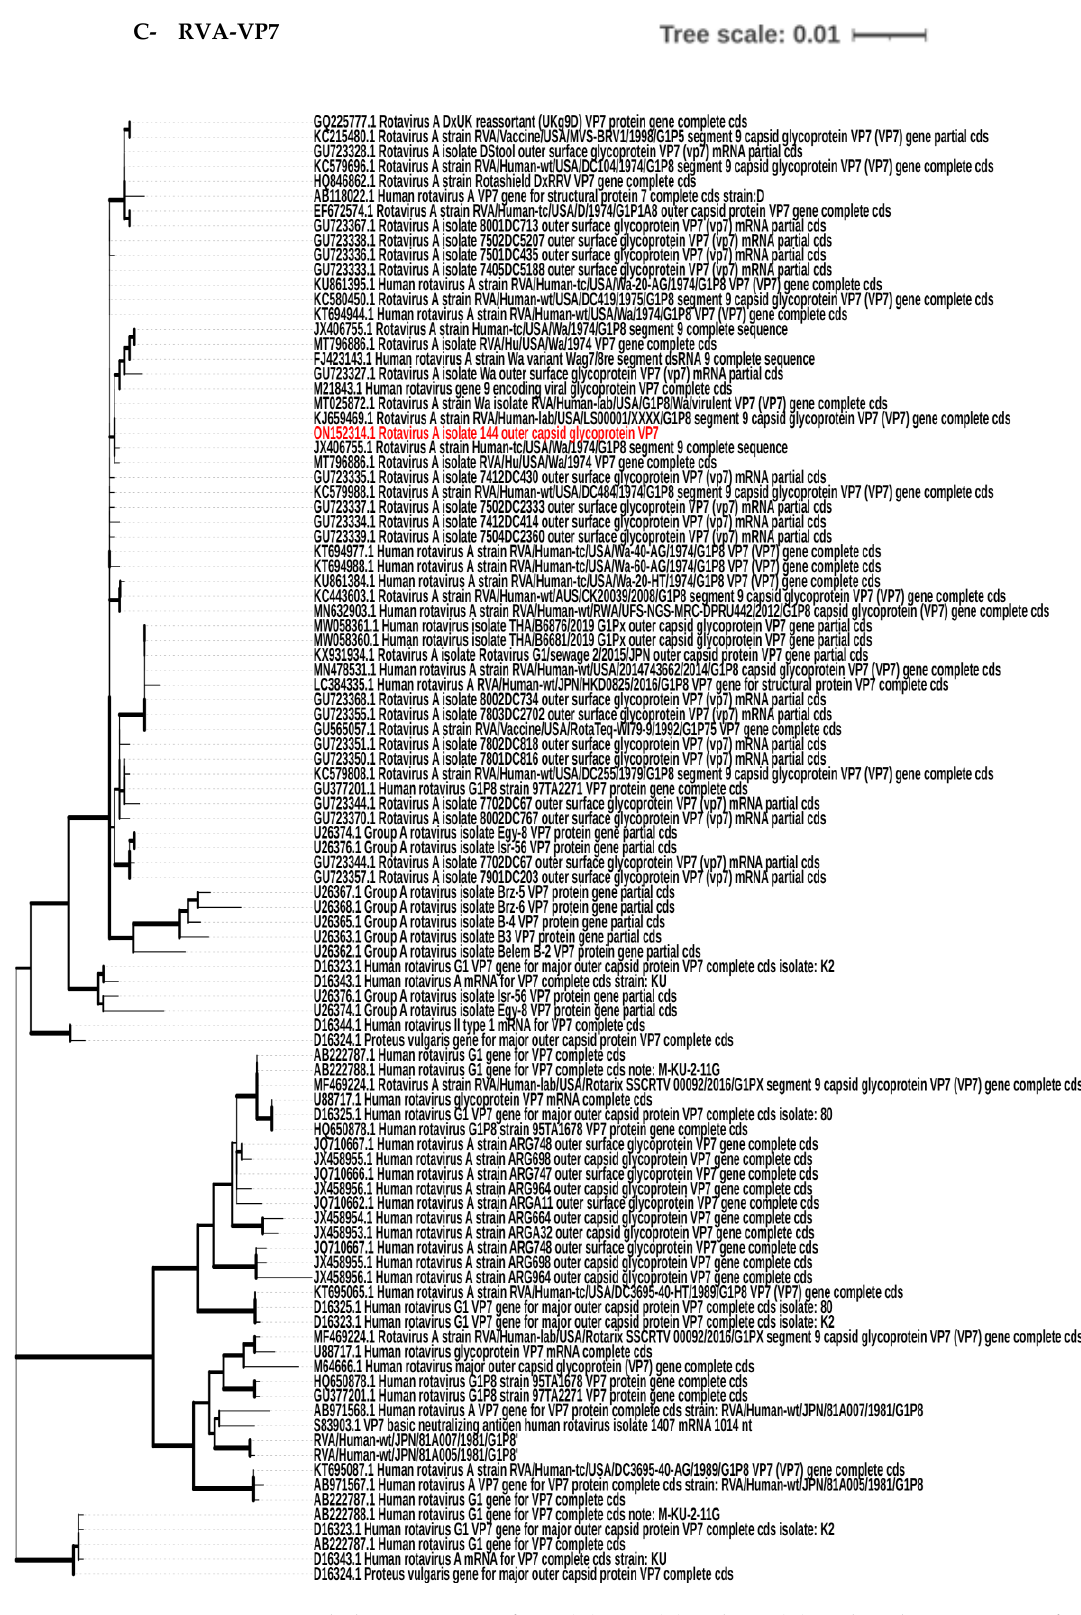
Figure 3. Phylogenetic trees of VP4 ( A ), VP6 ( B ) and VP7 ( C ) nucleotides’ sequences of RVA144 strain (labelled by the red color) detected among Egyptian children rotavirus cases showing their genetic relationship with the other human RVA s. This analysis involved 100 nucleotide sequences. The tree was generated by the Maximum Likelihood (ML) method with bootstrap (1000 iterations) analyses using the MEGA X software v.10.1.7